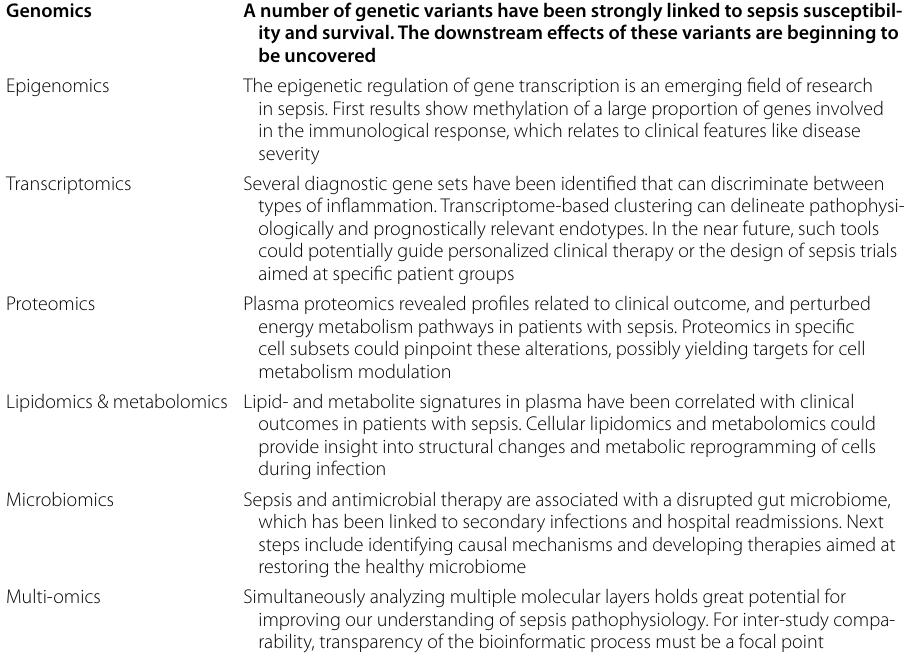
Table 1 Selected highlights of advances per -omics field